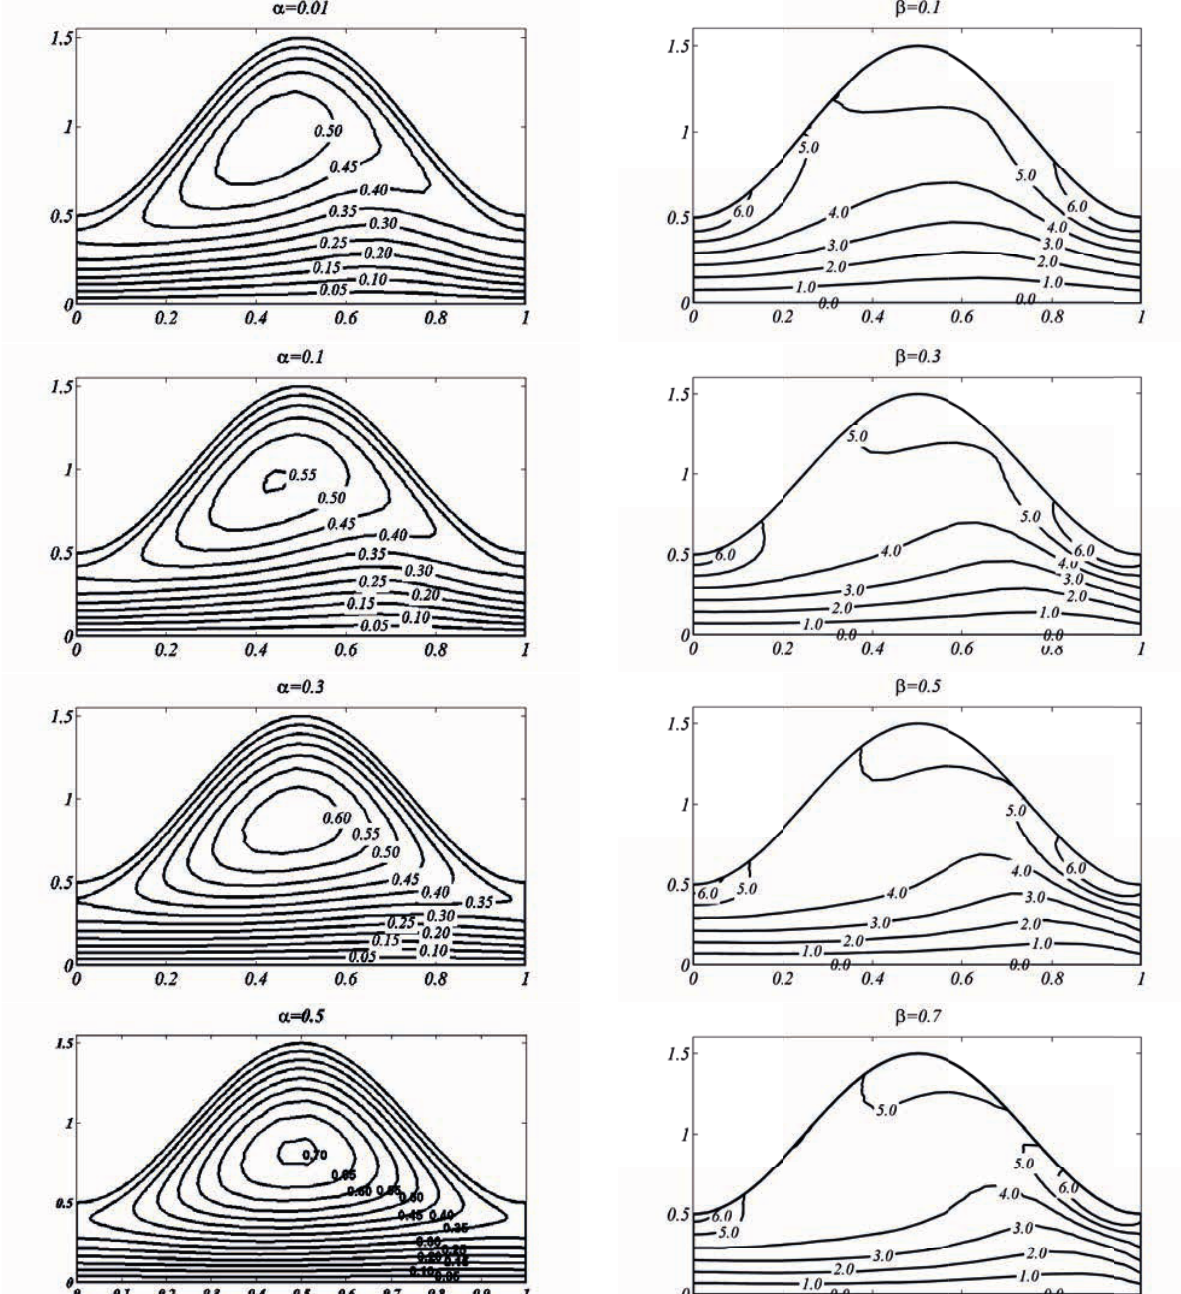
nance of inertial forces to viscous forces causes augmen- tation in a rise in pressure and this fact is not reported in previous studies. Furthermore, increasing wave num- ber shows analogous behavior as of Reynolds number pre- sented in Figure 13(b). The free pumping in this case